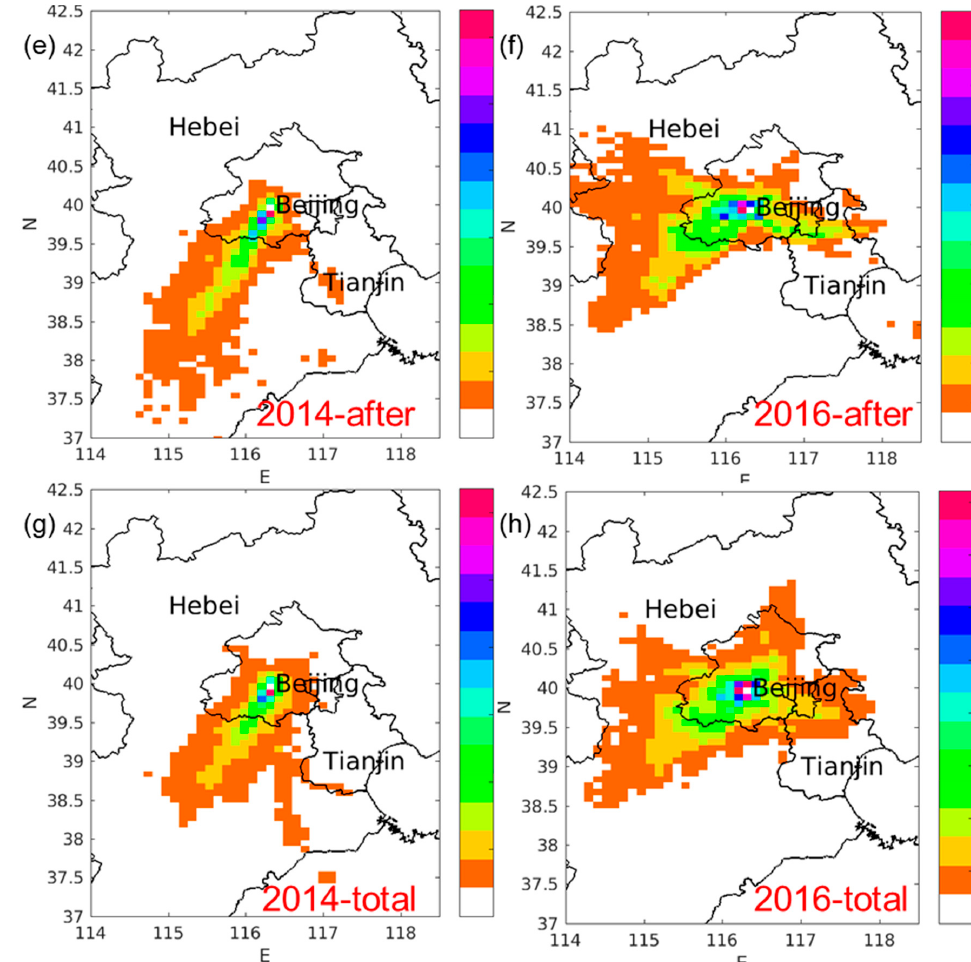
Figure 11. PM 2.5 CFAs comparison of 2014 and 2016 during the same sampling periods. Subplots ( a , c , e , g ) are the CFAs of the four periods in 2014. Subplots ( b , d , f , h ) are the CFAs of four periods in 2016. Other configurations and set-ups are the same in the MATLAB calculation scripts. From bottom to top side of the color bar, the cell contribution gets higher. In the year 2014, the “during” and “after” periods almost showed the same air mass transport patterns (Figure 10a,c,e,g). In these two periods, the southwestern path was the dominant transport path, and some related cities like Baoding, Langfang, Shijiazhuang, and Xingtai became the air mass source region, while the “before” period showed massive short-range transport and local regions was the dominant air mass source region. In the “before” period, most of the Beijing city area contributed air mass significantly to the Olympic park site, and only some surrounding counties in Tianjin, Zhangjiakou, Baoding,